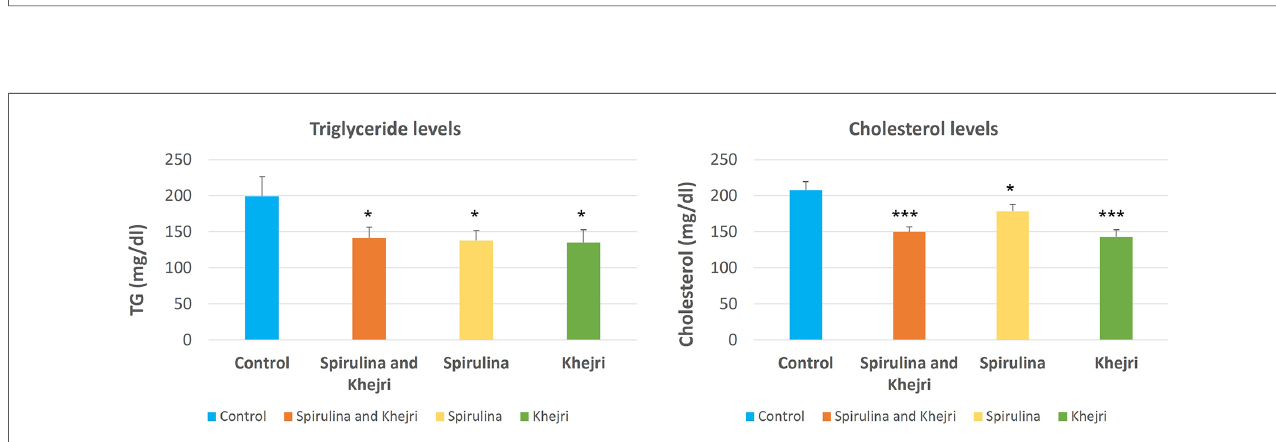
FIGURE 3 Triglyceride and cholesterol levels comparison in cricket players ( n =10) between pre and post-intervention period of 21 days supplementation with Khejri, * p <0.05, ** p <0.01, *** p